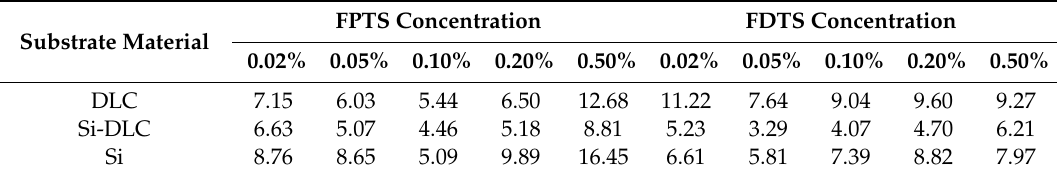
Table 1. Thickness [nm] of SAMs created on different substrates using LPD method using the solutions of FPTS and FDTS compounds at five different concentrations, estimated in FTIR measurements. Relative uncertainty is lower than 2%.